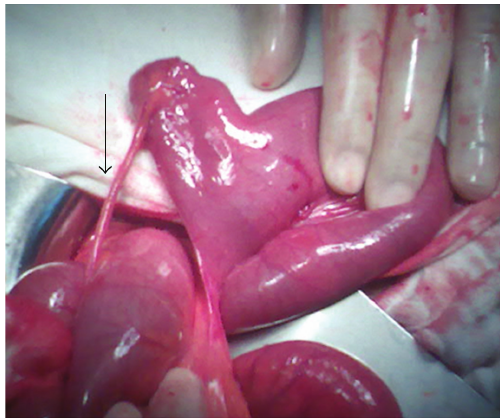
Figure 1: Meckel’s diverticulum and mesodiverticular band (arrow).